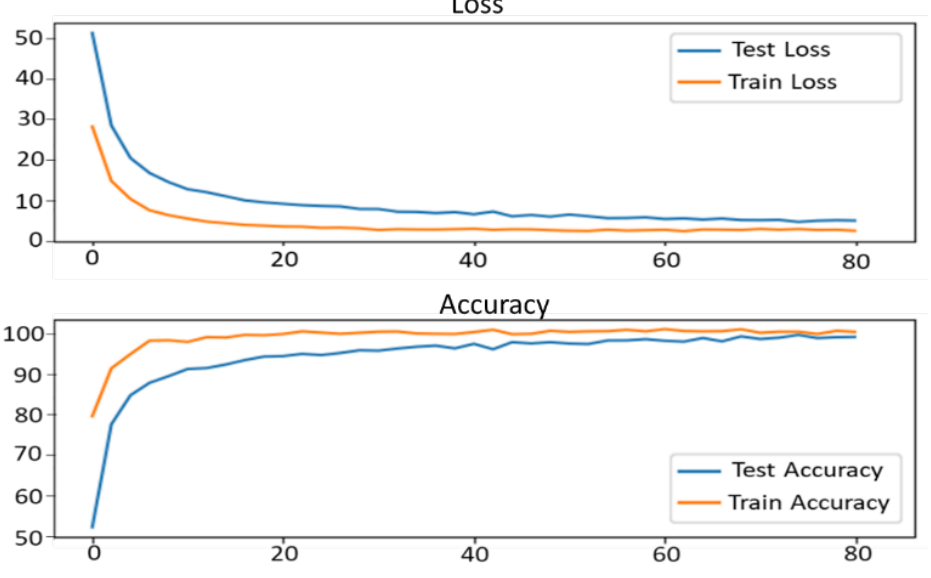
Figure 7. Performance evolution of the proposed model.